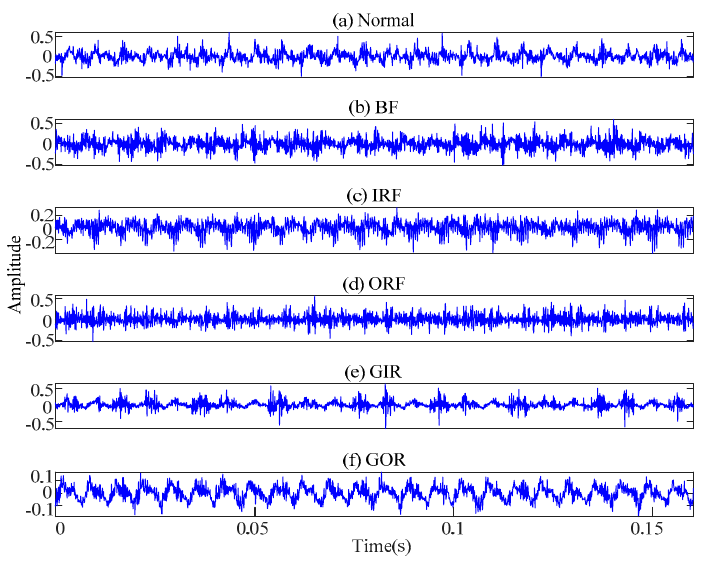
Figure 12. The time domain waveforms of rotating machinery under six healthy conditions in Experiment 1: ( a ) health condition (Normal), ( b ) ball fault (BF), ( c ) inner race fault (IRF), ( d ) outer race fault (ORF), ( e ) grooving in the inner race (GIR), ( f ) grooving in the outer race (GOR). Table 1. Detailed information of six conditions in Experiment